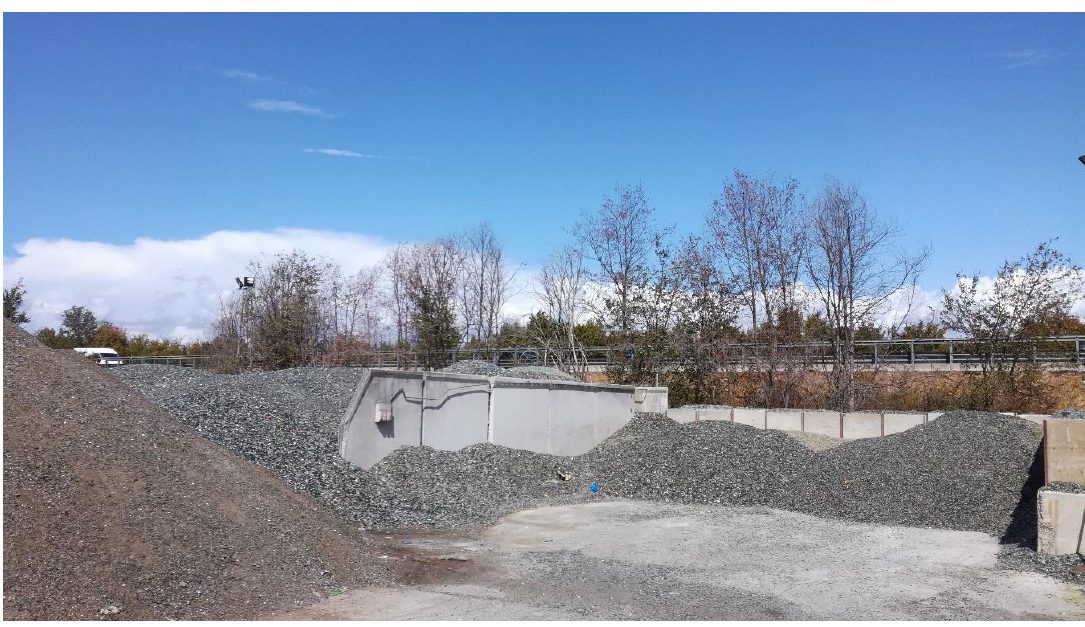
Figure 1. A part of the differentiated waste stockpile area.